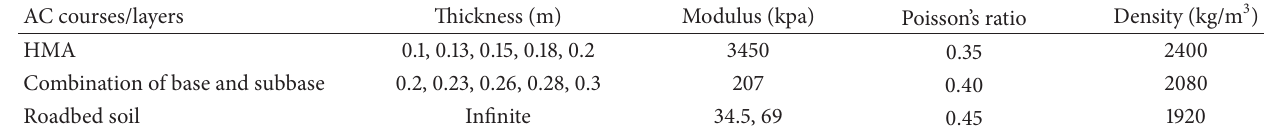
Table 2: Range of pavement cross section and material properties used in sensitive analysis.